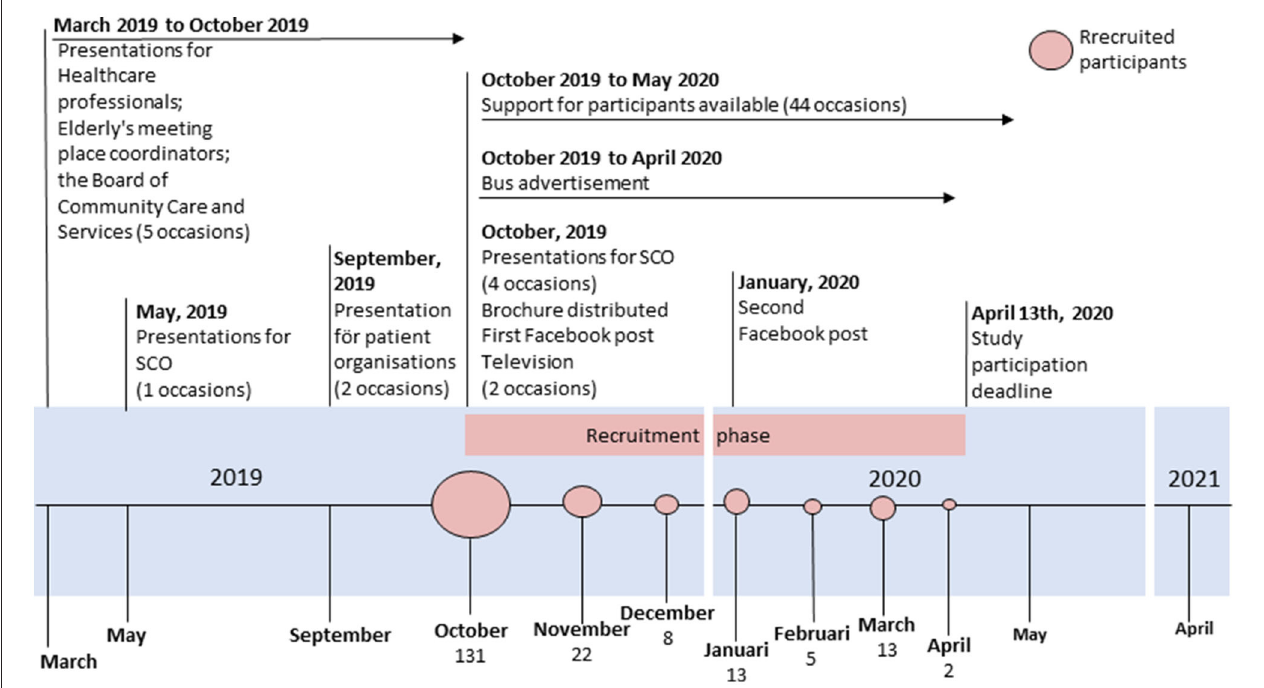
FIGURE 1 | Timeline of recruitment strategies and total number of participants recruited. SCO = senior citizen